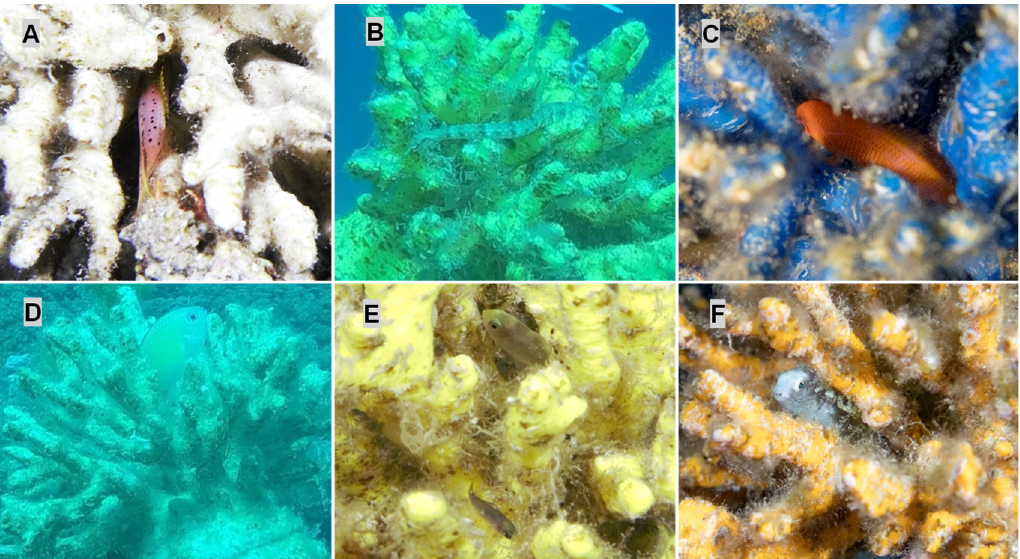
Figure 5. Fish interacting with artificial models. ( A ) Bodianus anthioides interacting with the brown model. ( B ) Corythoichthys cf schultzi interacting with the yellow model. ( C ) Pseudanthias squamipinnis interacting with the blue model. ( D ) Chromis viridis interacting with the brown model. ( E ) Neopomacentrus miryae interacting with the yellow model. ( F ) Meiacanthus nigrolineatus interacting with the orange